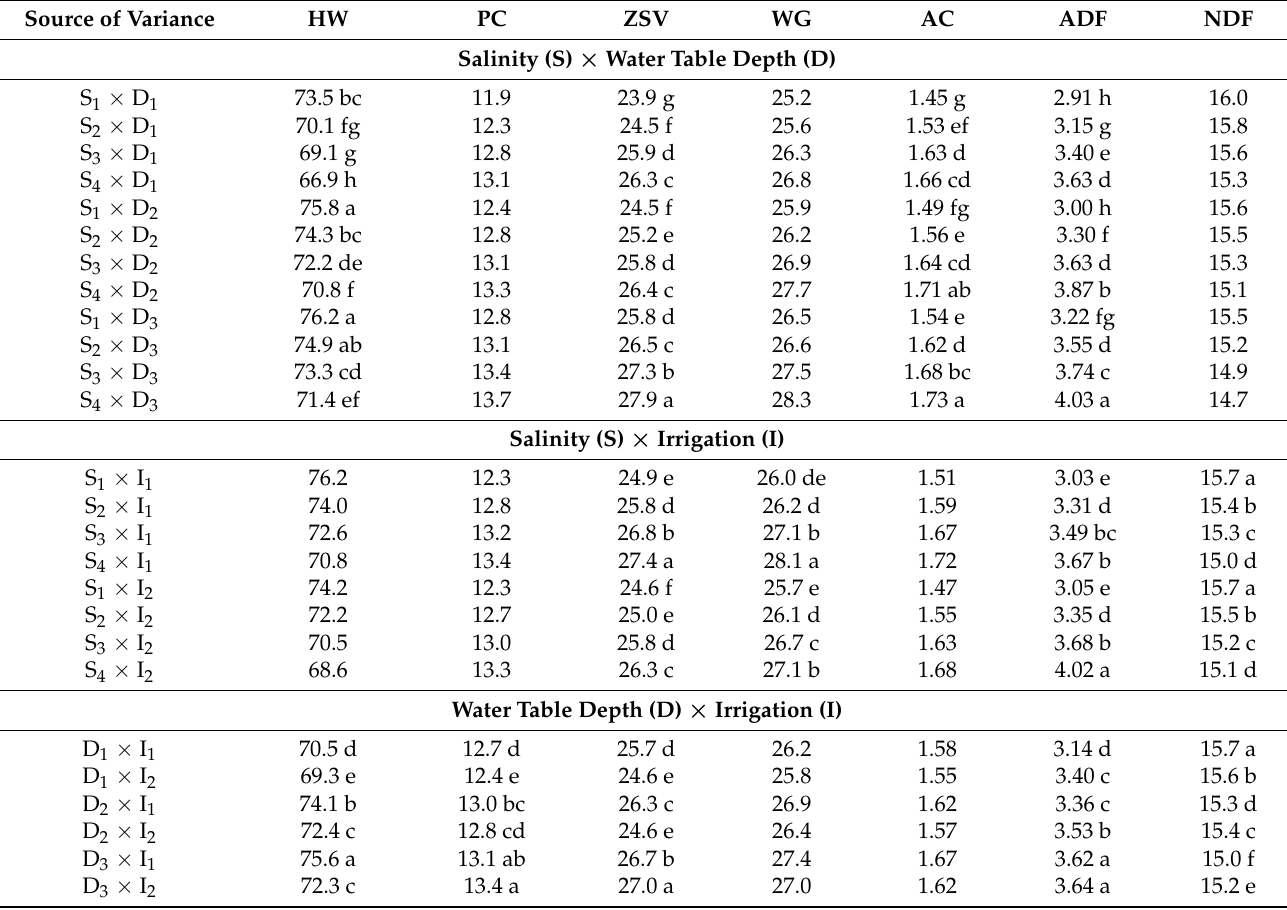
Table 5. The mean of the two years for the interaction effects of the salinity level × water table depth, salinity × irrigation, and water table depth × irrigation on the wheat parameters